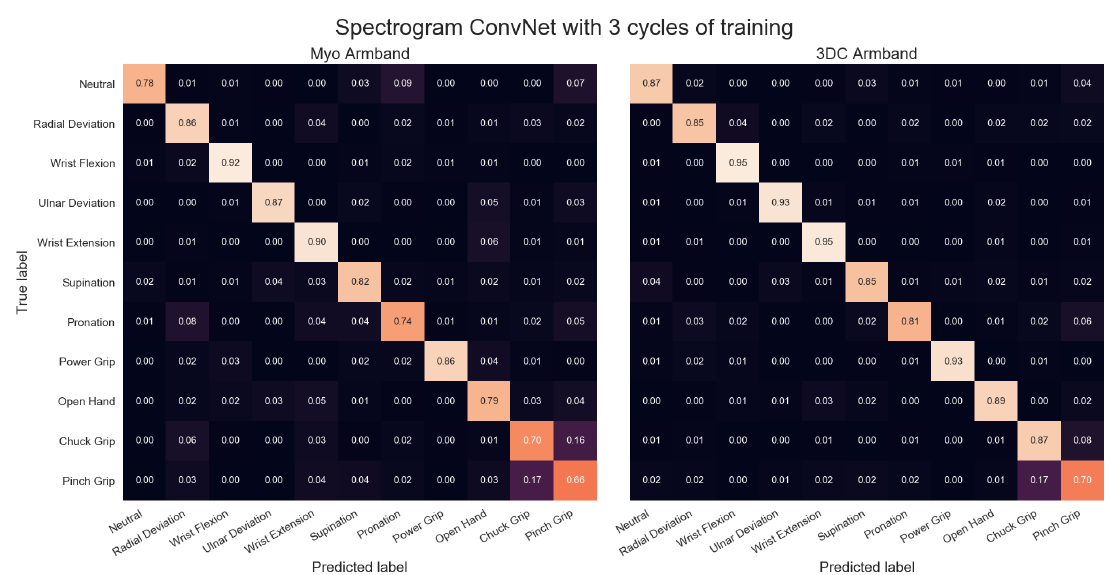
Figure A9. Confusion Matrices for the Myo and the 3DC Armband employing the Spectrogram ConvNet for classification and three cycles of training. Lighter is